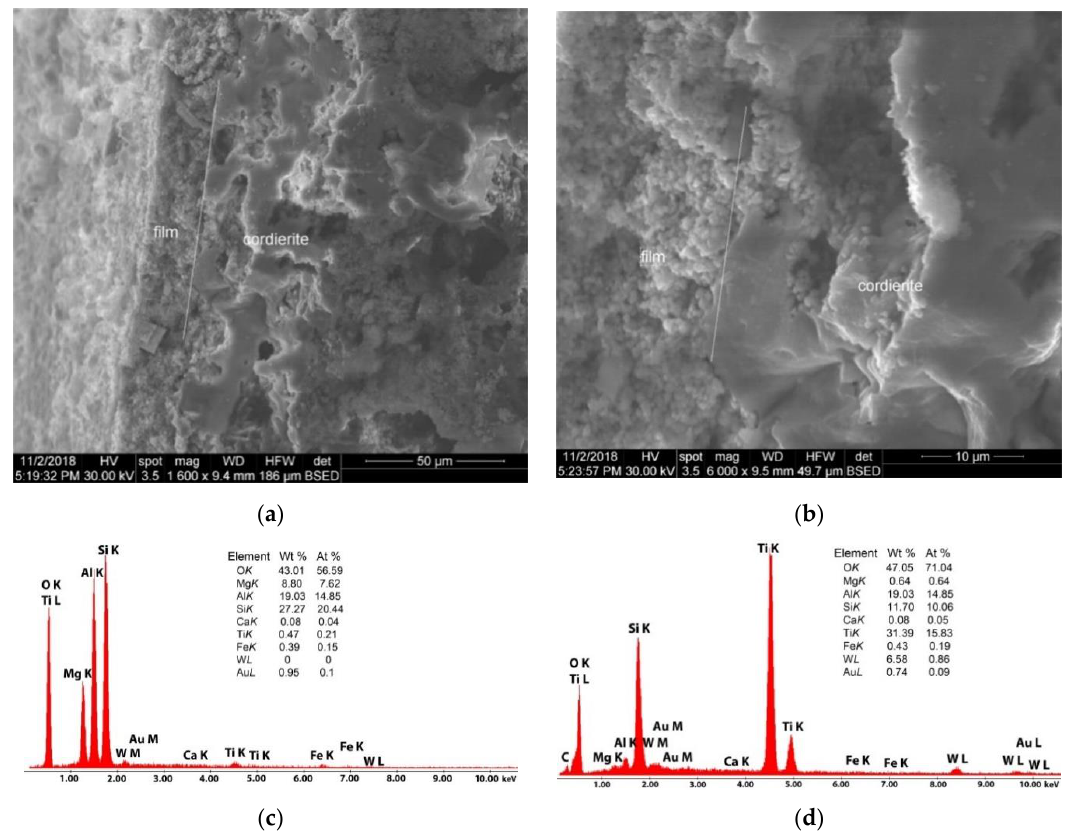
Figure 4. SEM secondary electron image (SEI) micrograph of spent catalyst sediment at a scale bar of: ( a ) 50 µm and ( b ) 10 µm, and their associated EDX investigations along the cordierite ( c ) and catalyst film ( d ).